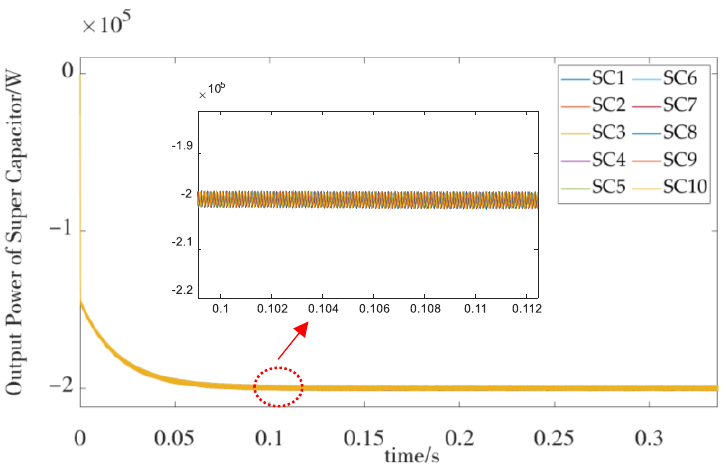
Figure 26. The output power of the SC